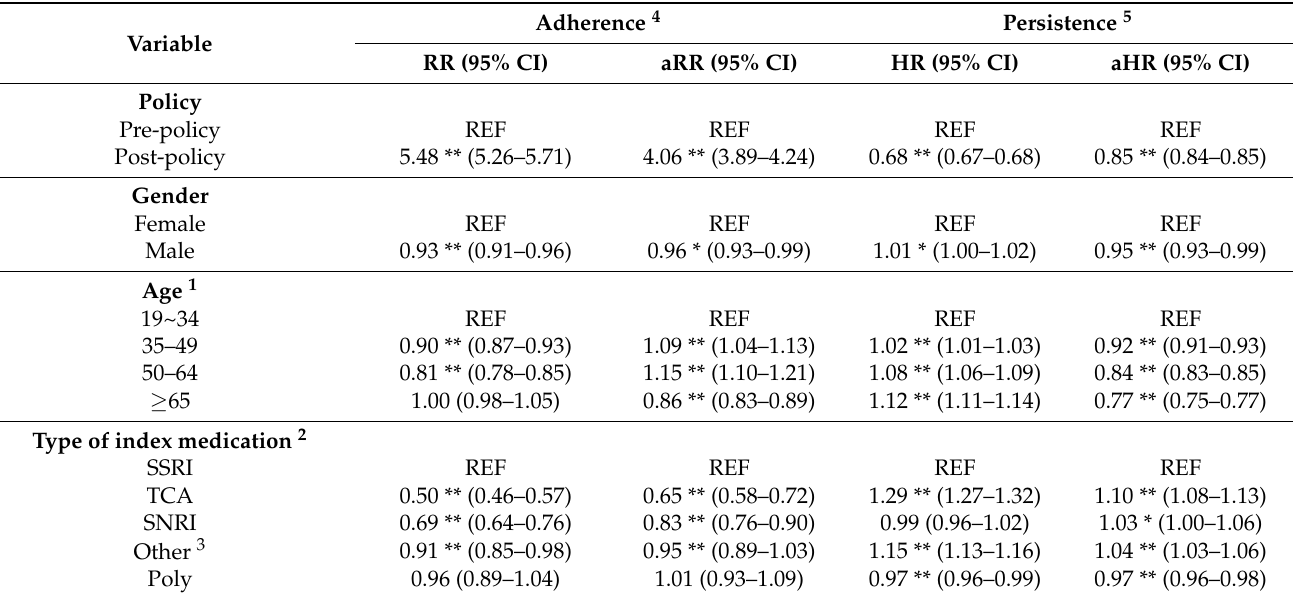
Table 4. Poisson generalized linear model (GLM) and Cox proportional hazards regression: estimate of medication adherence and